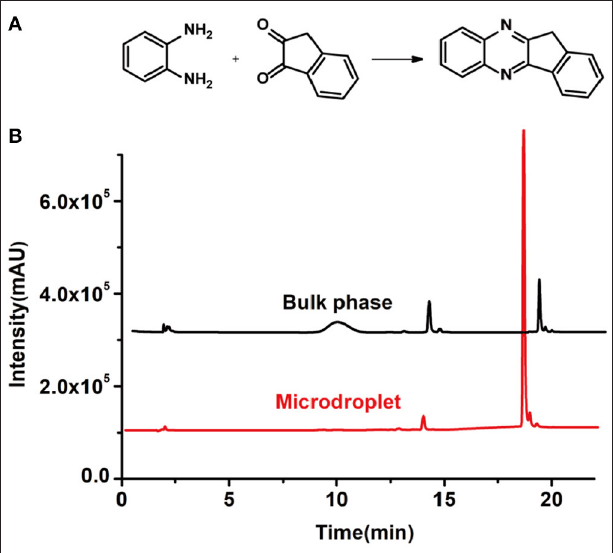
FIGURE 2 | (A) The model reaction of benzene-1,2-diamine and 1,2-indanedione. (B) Chromatogram of LC-MS for the model reaction under the optimal microdroplet condition (red line) and bulk phase (black line). The retention time is uniformly 18.6 min.